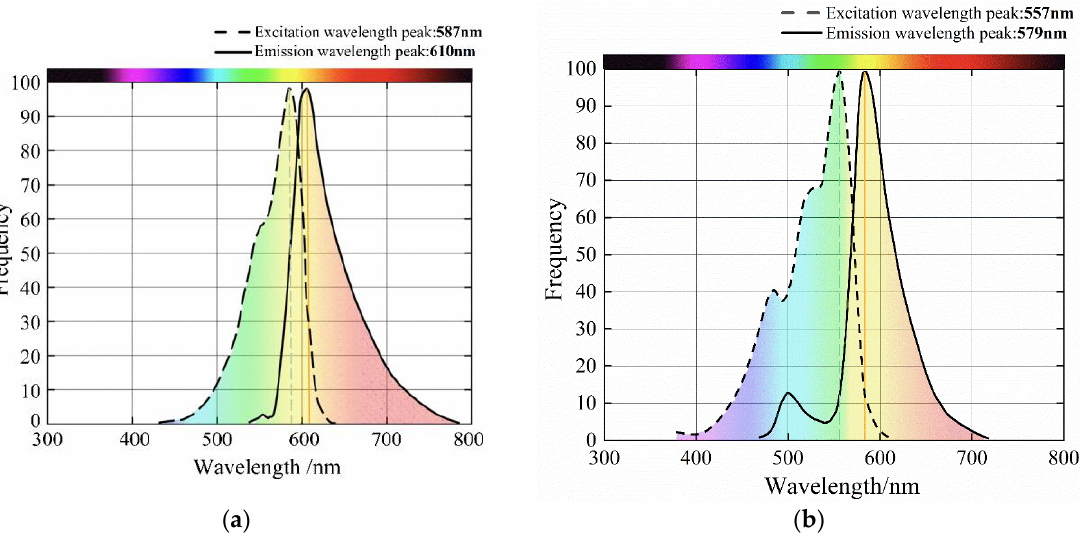
Figure 3. Fluorescent protein spectra: ( a ) mCherry, and ( b ) DsRed. Table 2. Excitation light source and filter configuration scheme for fluorescent maize kernels.